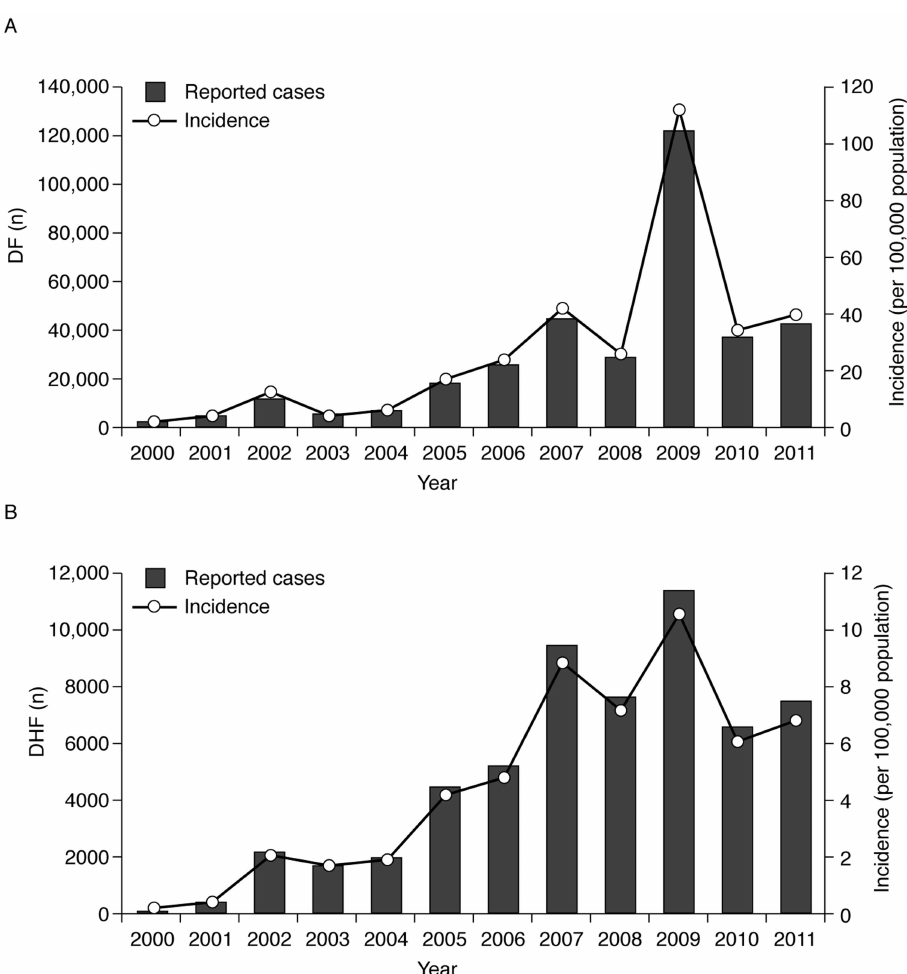
Figure 2. Reported number and incidence of dengue fever and dengue haemorrhagic fever cases, Mexico, 2000–2011 [20] . Over the period of the literature survey (2000–2011), the overall annual number of confirmed cases of (A) dengue fever (DF) and (B) dengue haemorrhagic fever (DHF) increased considerably in Mexico. The increase in number of cases and population incidence over time was not linear and peaks were observed in 2002, 2007, and